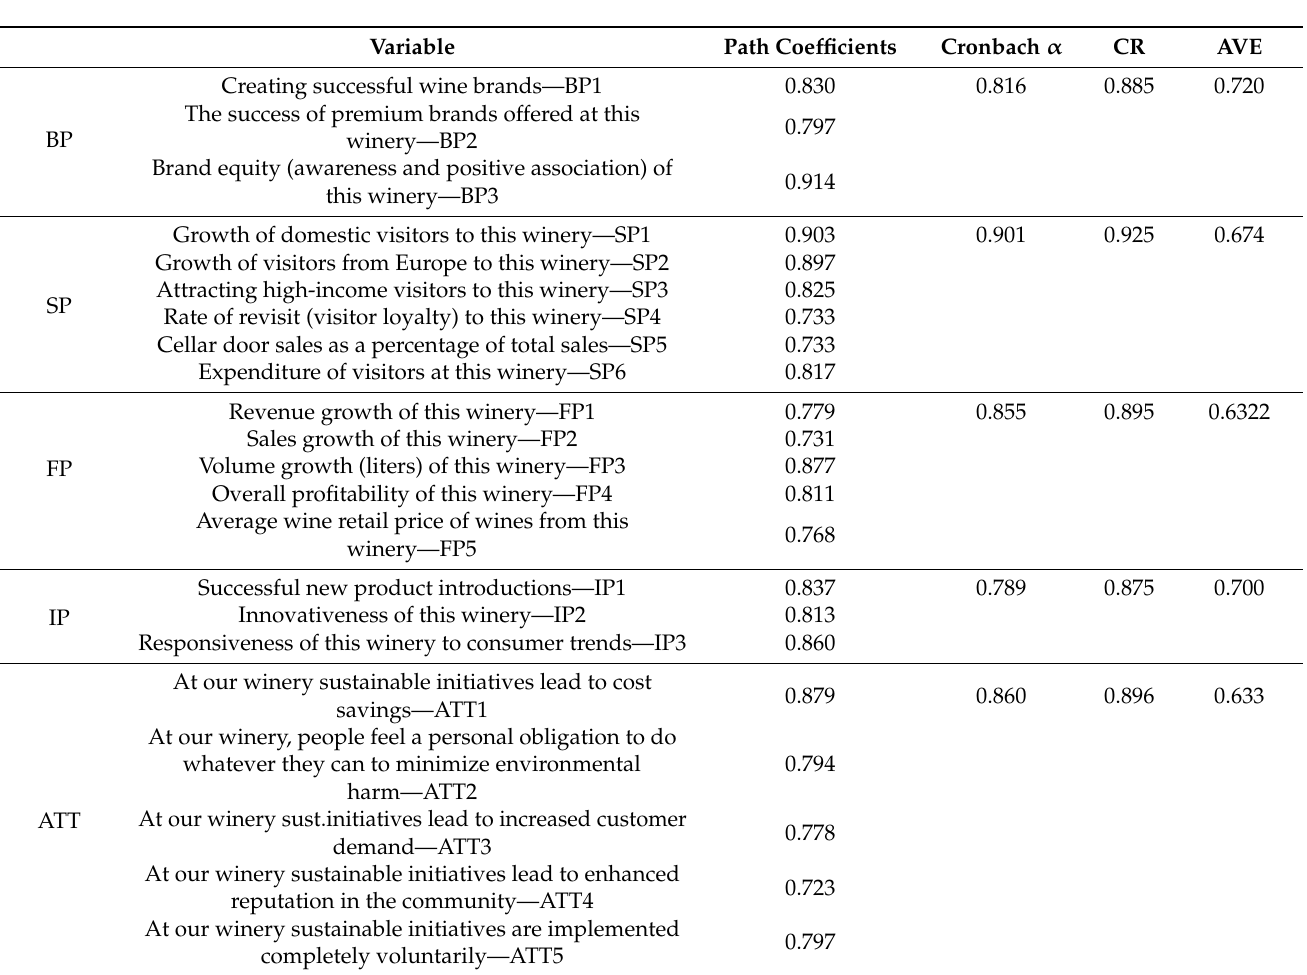
Table 1. Presentation of values of standardized factor loads and results of analysis of reflective measurement model.